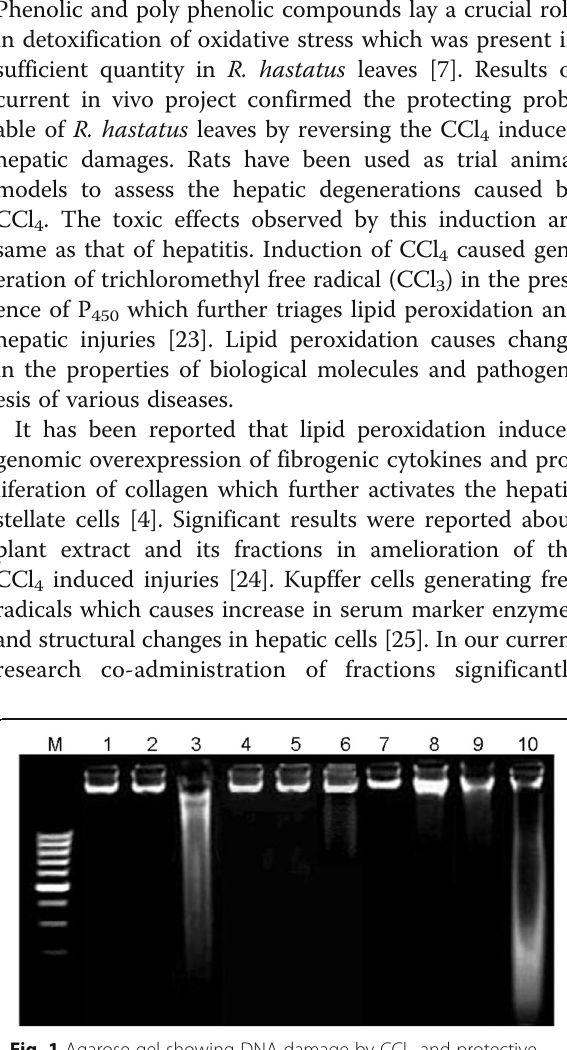
Fig. 1 Agarose gel showing DNA damage by CCl 4 and protective effect of R. hastatus